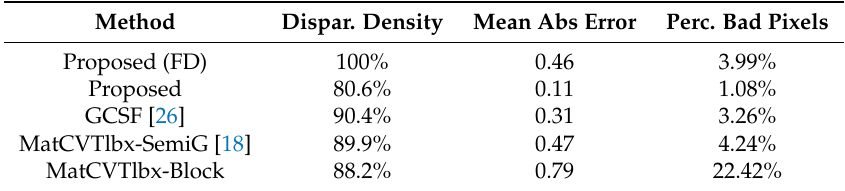
Figure 15. “Xenia” sequence: experimental results: estimated disparity map ( a ) before and ( b ) after the application of SO; ( c , d ) the corresponding estimation error results; ( e ) estimated flow field after the application of SO. Table 6. Comparative results for the “Xenia”